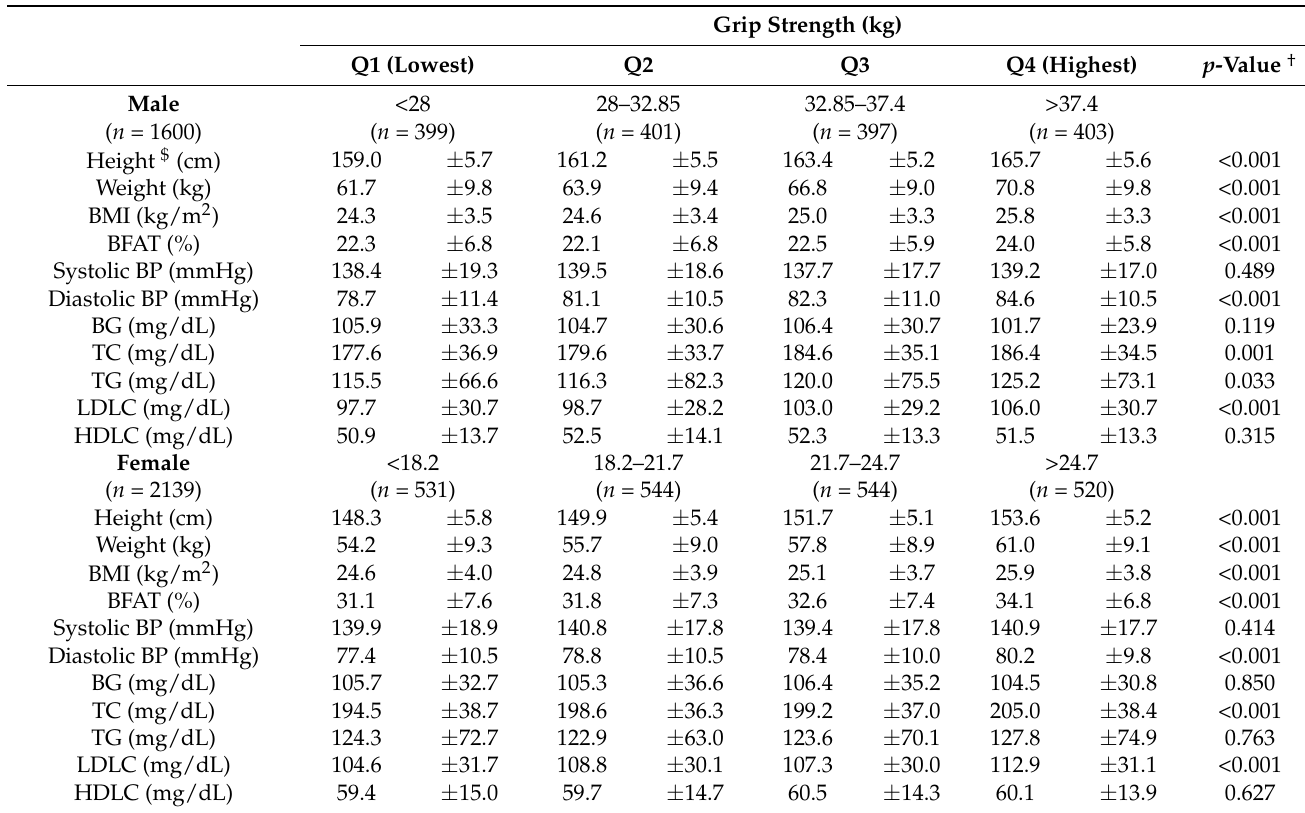
Table 1. Distributions of anthropometric variables and cardiometabolic risk factors among